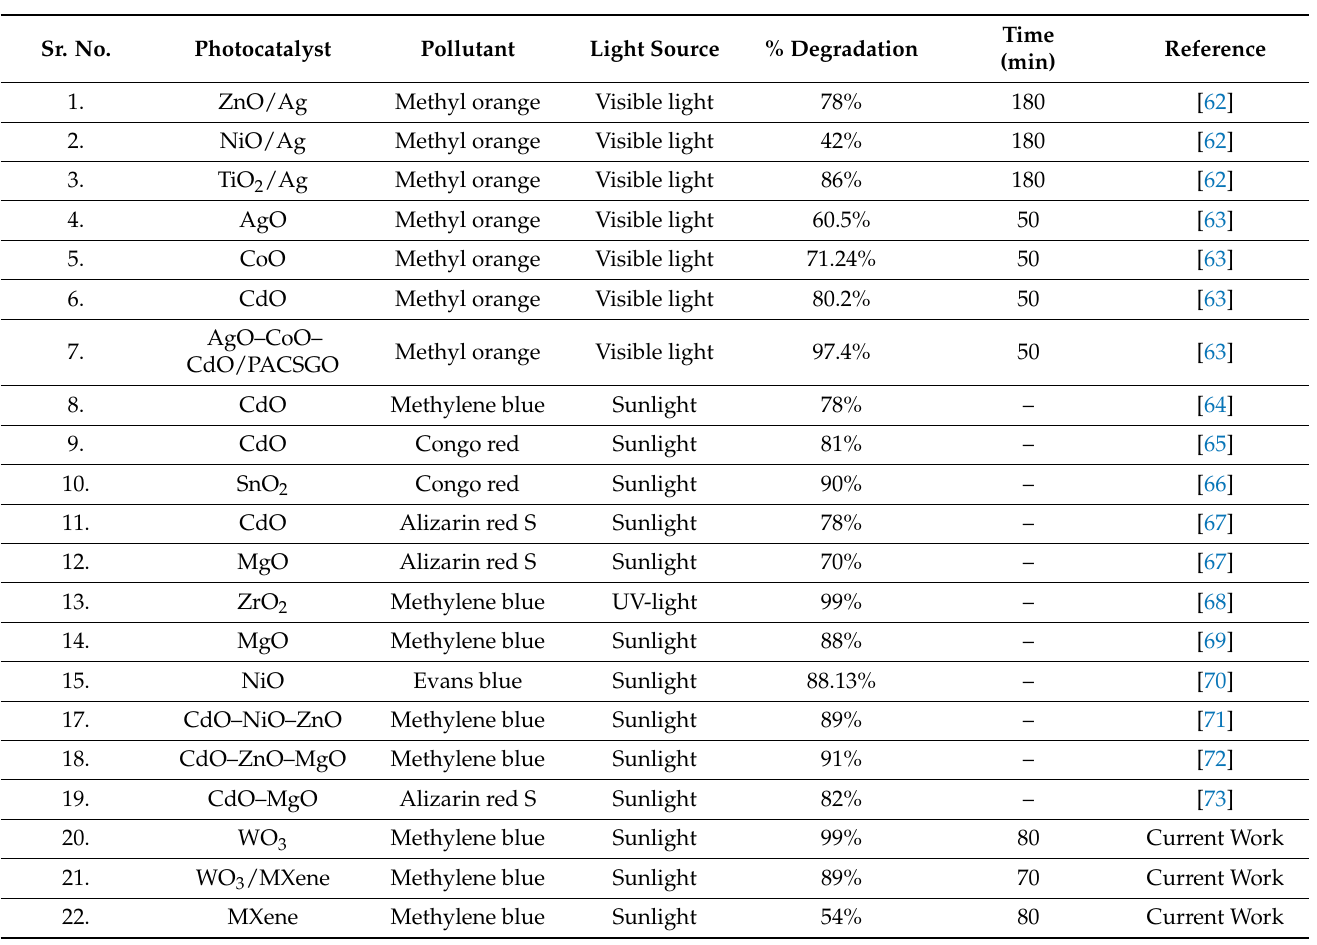
Table 2. Comparison between the degradation percentage of the current research with values reported in the